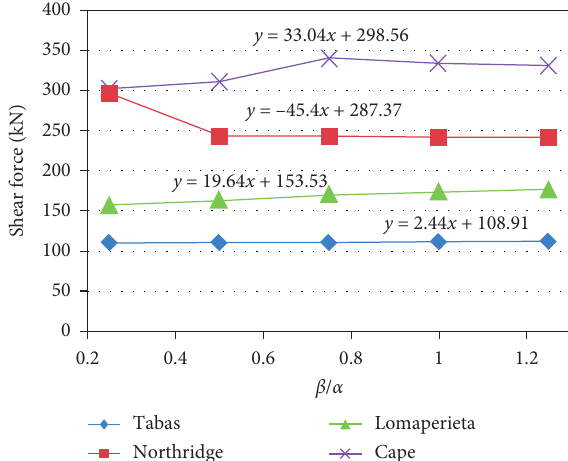
Figure 14: Maximum axial force of tunnel lining ( F ) at load combination 6 to 10.